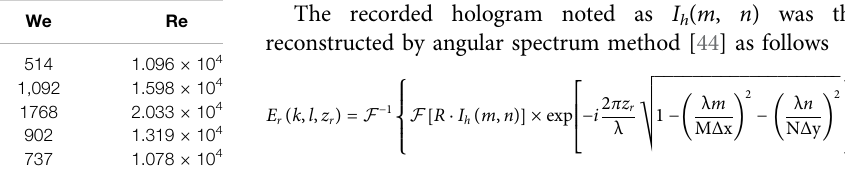
Frontiers in Physics |